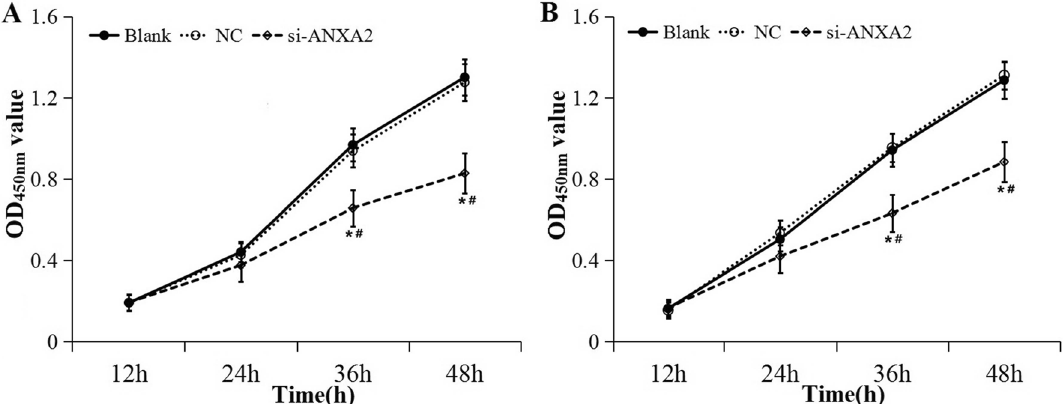
Figure 5. Effect of silencing ANXA2 expression on cell proliferation ability detected by CCK-8. ( A ) Cell proliferation ability of HSC-3 cells; ( B ) Cell proliferation ability of SCC-4 cells. Data were presented as the mean ± SD of at least three repeated experiments. * P < 0.05, compared with blank group; # P < 0.05, compared with NC group.